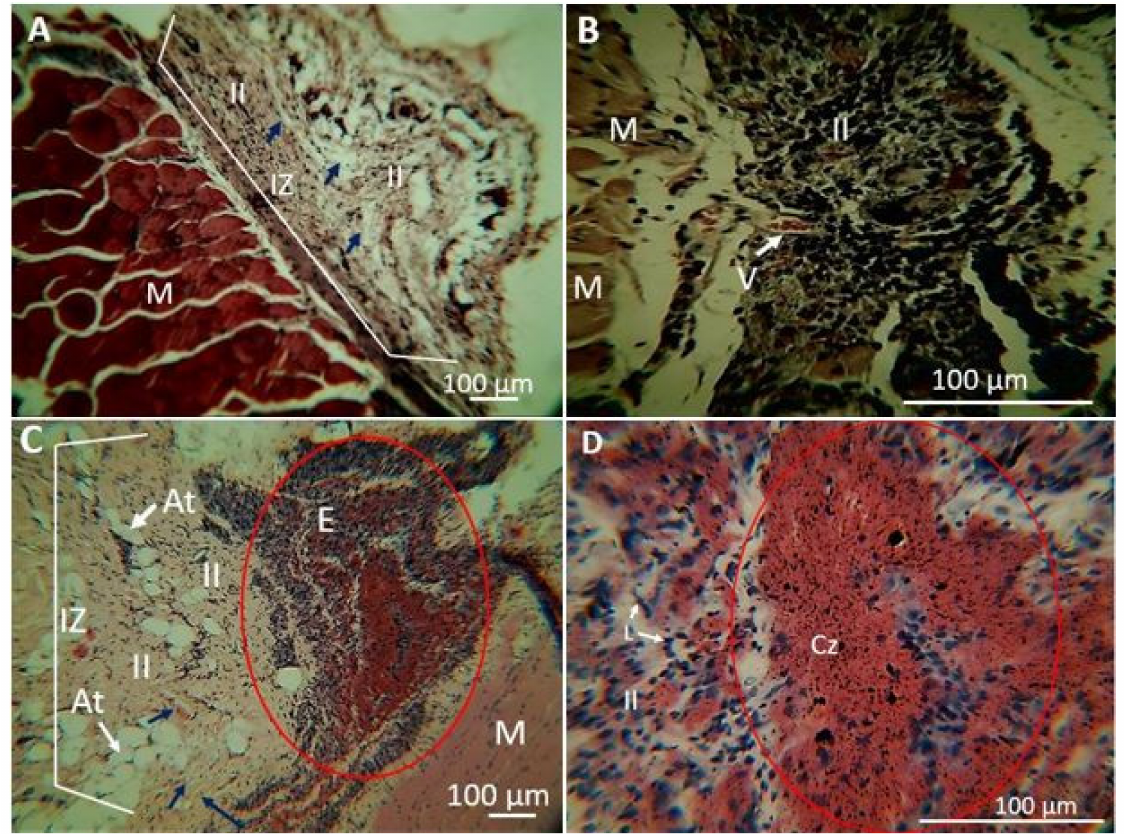
Figure 8. Nanocomposite F2 implanted in the Wistar rat subdermal area at 30 and 90 days. ( A ) at 10 × implantation at 30 days. ( B ) at 40 × implantation at 30 days. ( C ) at 10 × implantation at 90 days. ( D ) at 40 × implantation at 90 days. IZ. Implantation area. II: Inflammatory infiltrate. M: Muscle. V: Blood vessel. L: Lymphocytes. Blue arrows: implanted material. Red oval: extravasation zone during sample recovery. E: erythrocytes Cz: coagulation zone. Hematoxylin and Eosin Technique